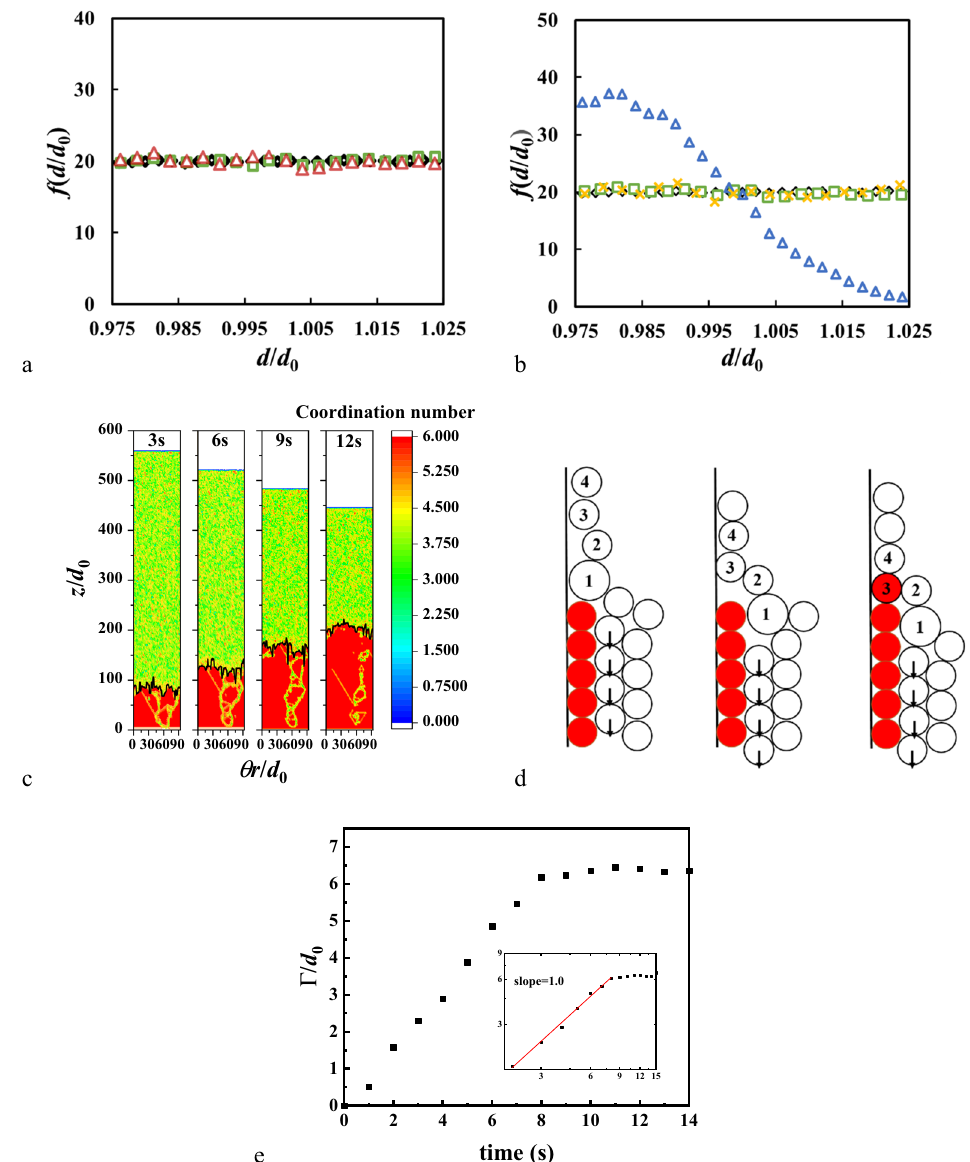
Figure 2. ( a ) Frequency distribution of initial radial coordination of shell particles. Size distribution of different particle groups with ( a ) μ pp = 0.5; ( b ) μ pp = 0.05. Diamond (black): all particles in the hopper. Square (green): particles at the boundary when the flow starts. Upper triangle (blue): the shell particles when the drainage is over. X (yellow): the boundary particles above the upper surface during the drainage. Upper triangle (red): the boundary particles when flow is stable. ( c ) Side area of the cylindrical hopper at different time (3, 6, 9, 12 s after the flow starts), showing the growth of the crystallized shell. The color denotes the coordination number of wall particles. The red particles are shell particles. Black lines denote the local surface of the shell. ( d ) Illustration of the shell growth. The red particles denote the shell particles. The proper size particle (particle 3) is selected by settling down process while particles 1 and 2 flow aside. ( e ) Development of roughness of surface Ŵ( t )